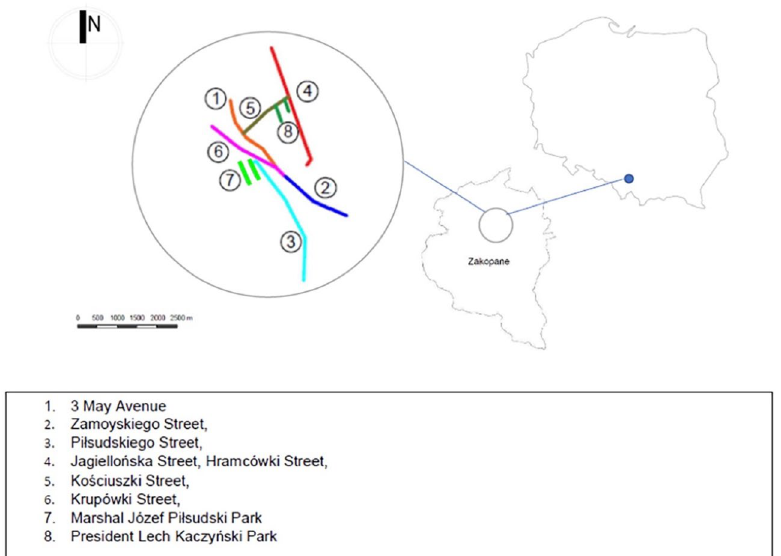
Figure 1. Location of all the studied trees ( Source : Own